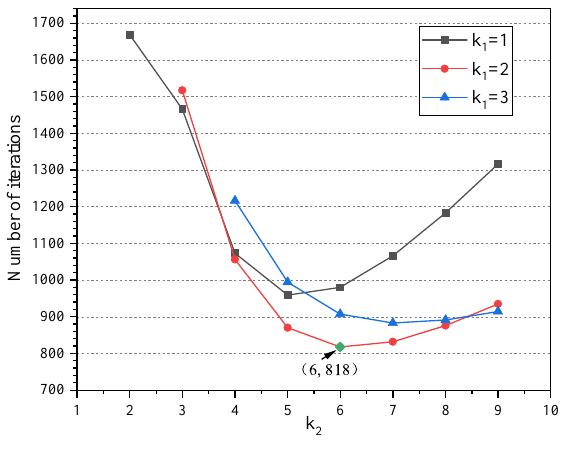
Figure 7: The relationship between ( k 1 , k 2 ) and the number of